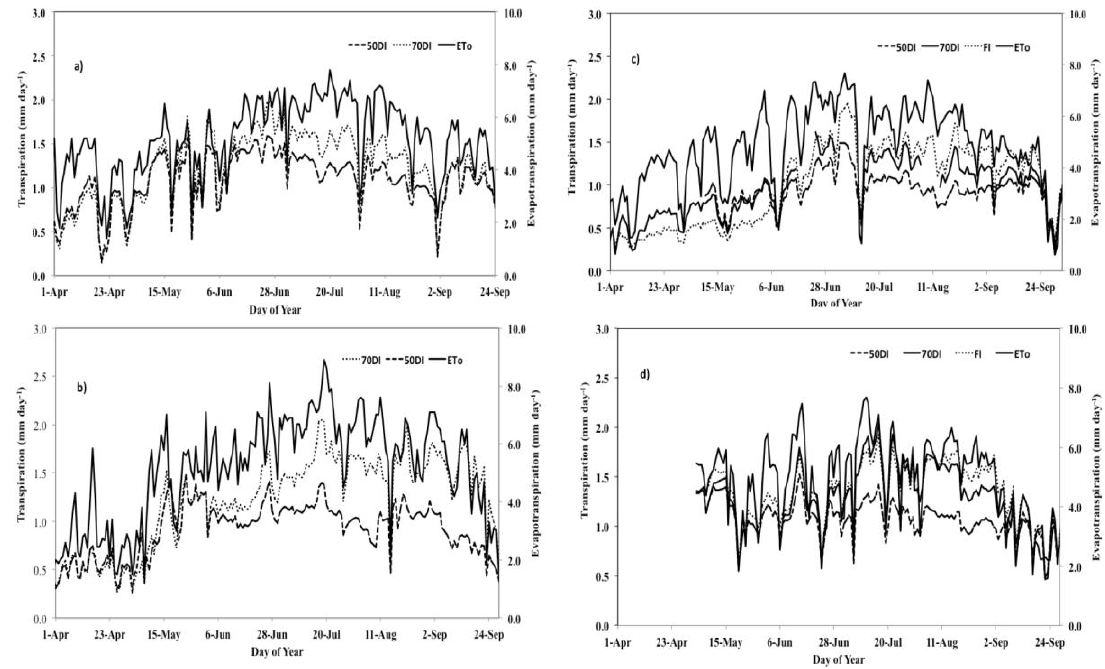
Figure 2. Daily evapotranspiration (ETo) and transpiration rates obtained from sap flow measurements for full irrigation (FI), 70% deficit irrigation (70DI), and 50% deficit irrigation (50DI) regimes applied to olive orchards: ( a ) 2011, deficit irrigation (DI) treatments; ( b ) 2012, DI treatments; ( c ) 2013, all irrigation treatments; ( d ) 2014, all irrigation treatments.